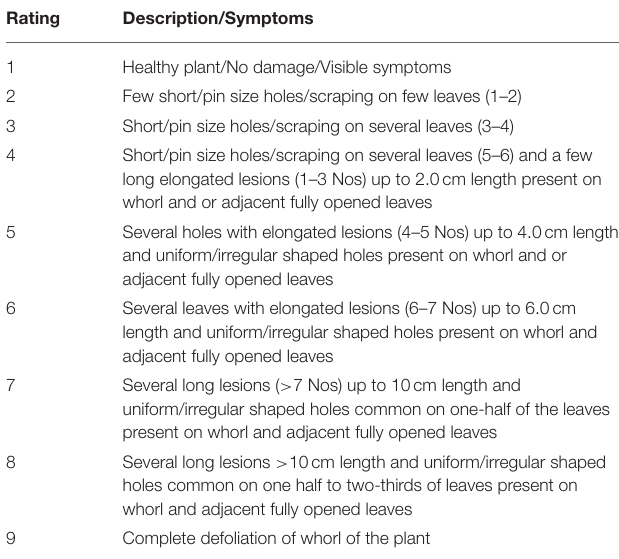
TABLE 2 | Leaf Damage Rating (LDR) scale to categorize maize germplasm for resistance to FAW (Modified from Davis and Williams, 1992; Ni et al.,